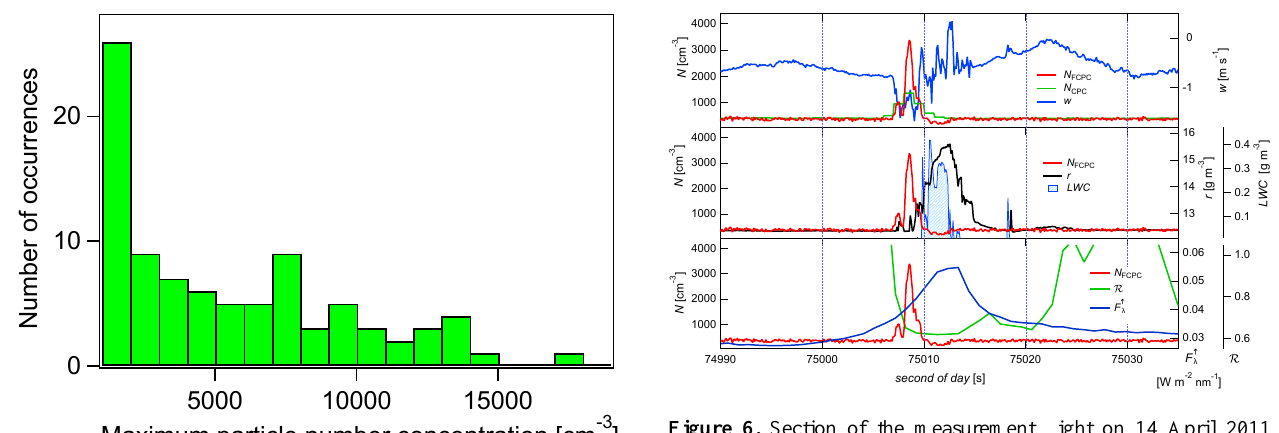
Figure 6. Section of the measurement flight on 14 April 2011 through a cumulus cloud. Presented variables are w (vertical wind ↑ speed), F (spectral upward irradiance at 333nm), r (water vapor λ mixing ratio), N CPC and N FCPC (total particle number concentra- tion measured by CPC and FCPC), LWC (liquid water content), and R (cloud